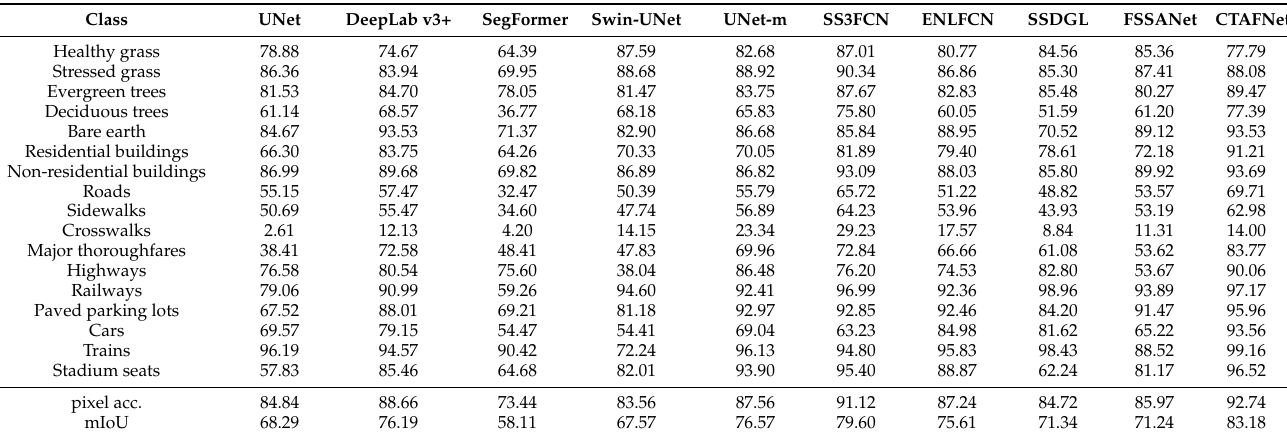
Table 6. Classification results for the DFC2018 test set.